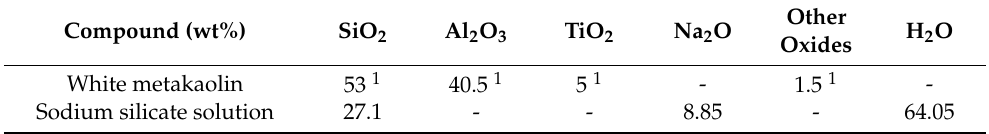
Table 1. Chemical composition of the